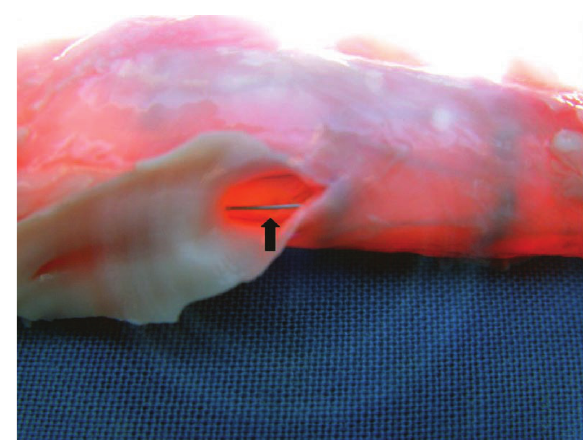
Fig. 5 - Visão externa da aorta abdominal com uma haste metálica do stent (setas), passando sobre o óstio da artéria renal, sem sinais de obstrução e visualização da parede aórtica